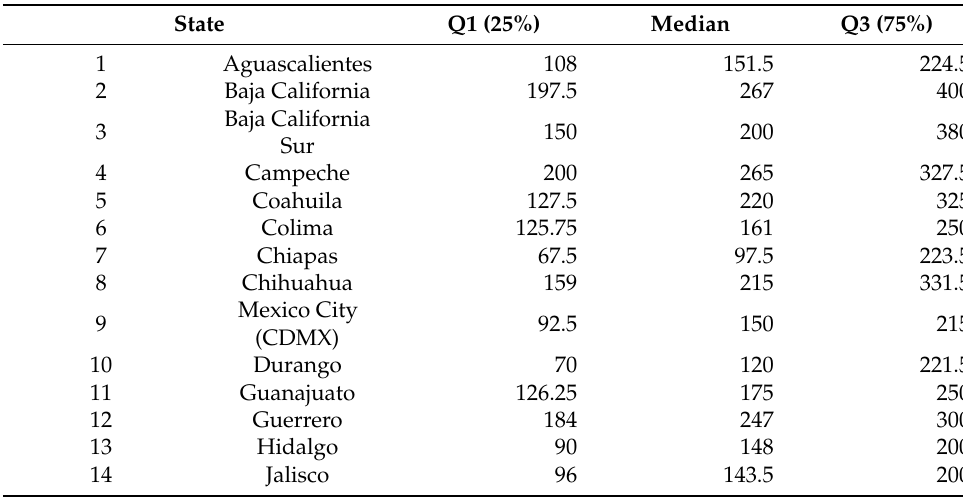
Table A1. Statistics used to build the electricity bill